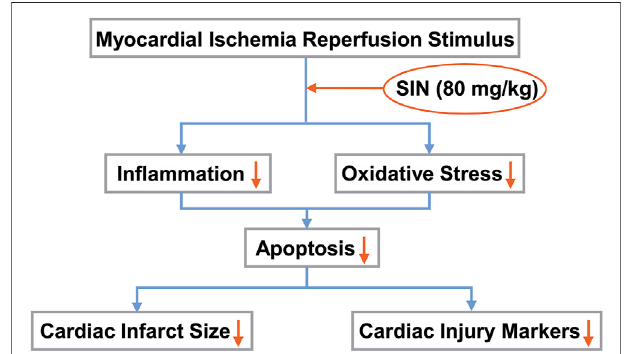
FIGURE 6 | Schematic illustration showing that SIN provides protection against MIRI by preventing oxidative stress and in fl ammation. Pretreatment with SIN attenuated MIRI-induced in fl ammation and oxidative stress, thereby reducing cellular apoptosis and improving myocardial infarct size and markers of cardiac